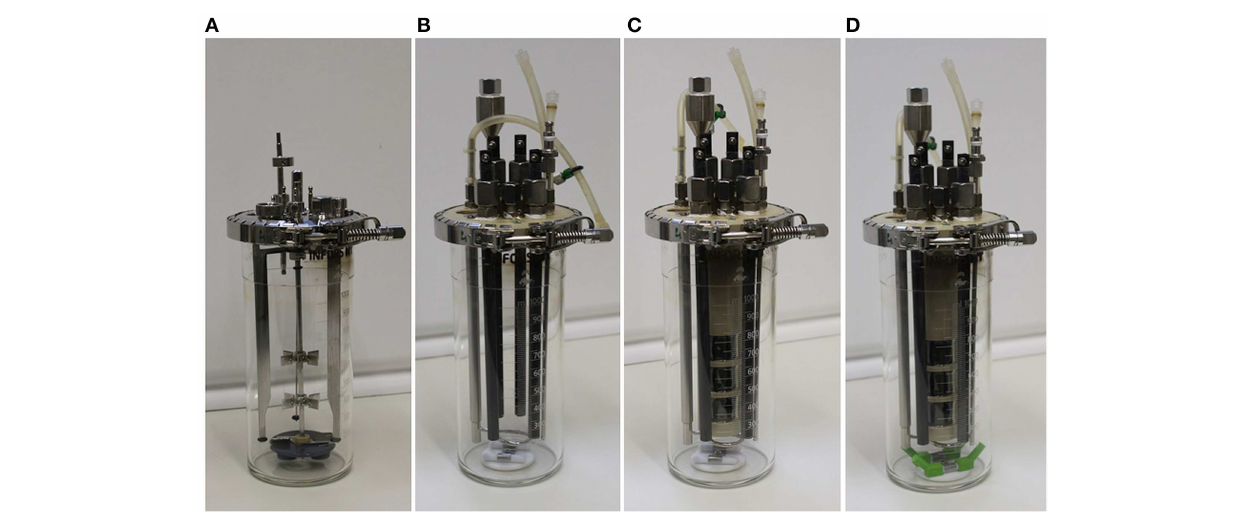
FIGURE 1 | Pictures of the different experimental setups described in the text in detail. (A) Bioreactor of the manufacturer (setup 1); (B) upgrade kit for bioreactors including working and counter electrodes, without chamber inlay, and with the standard upgrade kit stirrer (setup 2); (C) upgrade kit for bioreactors complete with membrane chamber inlay (setup 3); (D) upgrade kit for bioreactors complete with membrane inlay and a modified stirrer with extensions (setup